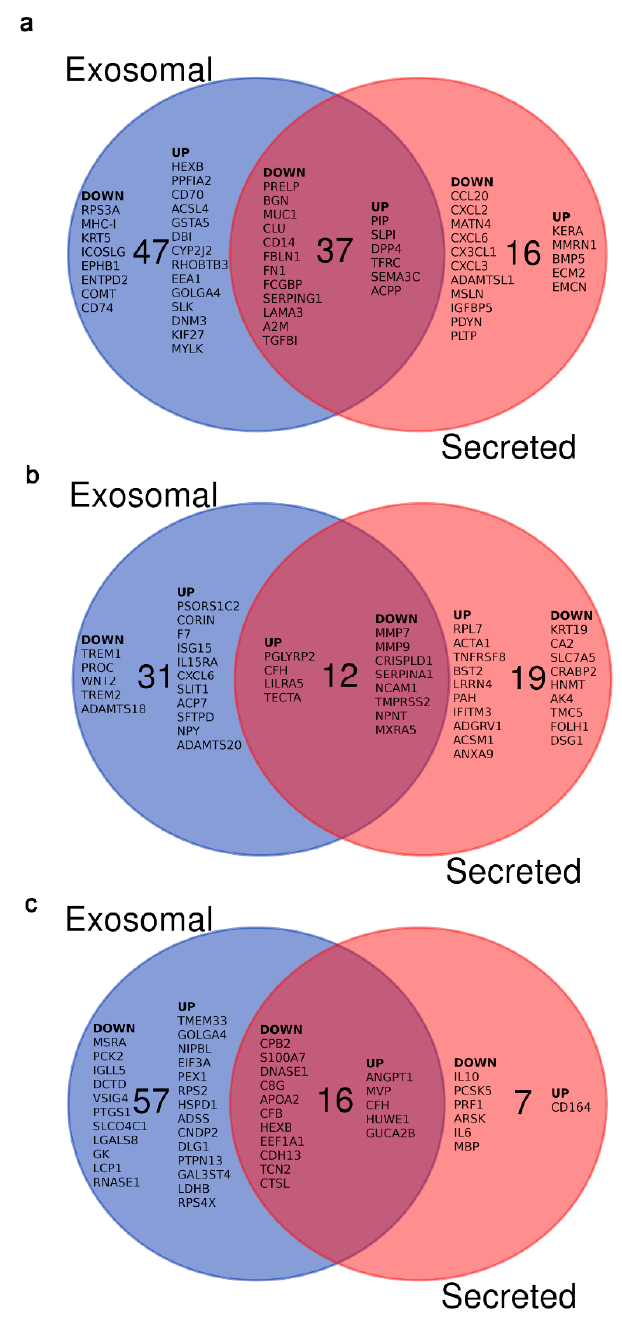
Figure 2. Analysis of the DEG in the oviduct of non-pregnant and pregnant animals related with secreted and/or exosomal proteins. ( a ) Differentially expressed genes coding for exosomal and/or secreted proteins in the ipsilateral oviduct of pregnant vs non-pregnant cows. Data taken from Maillo et al., 2015 [74]. When more than 20 genes were present in an area of the Venn diagram, gene names were selected according the highest fold change. ( b ) Differentially expressed genes coding for exosomal and/or secreted proteins in the ipsilateral oviduct of pregnant vs. non-pregnant mares. Data taken from Smits et al., 2016 [75]. ( c ) Differentially expressed genes coding for exosomal and/or secreted proteins in the pregnant vs. nonpregnant oviduct of sows. Data taken from Martyniak et al., 2018 [76]. When more than 20 genes were present in an area of the Venn diagram, gene names were selected according the highest fold change.